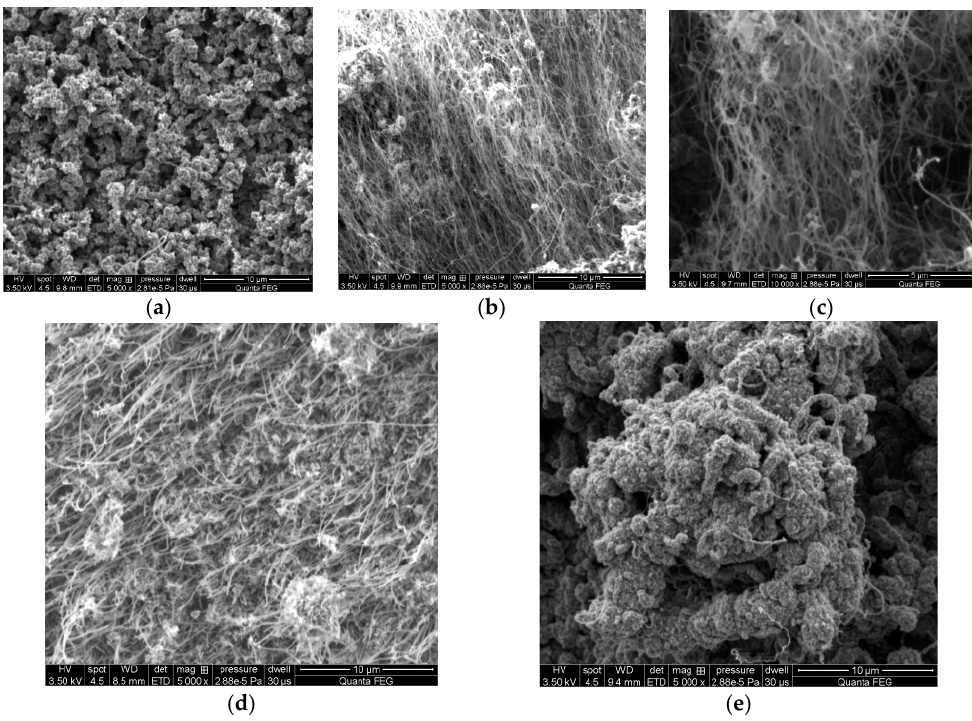
Figure 8. SEM images of the steel with carbon nanotubes synthesized at different temperatures ( a ) 1020 K; ( b ) 1050 K; ( c ) 1070 K; ( d ) 1100 K; ( e ) 1120 K.